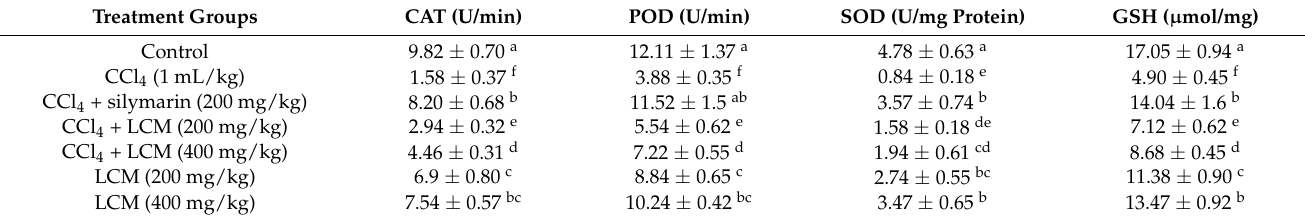
Table 6. Effect of different treatments with L. corymbulosum on liver tissue antioxidant